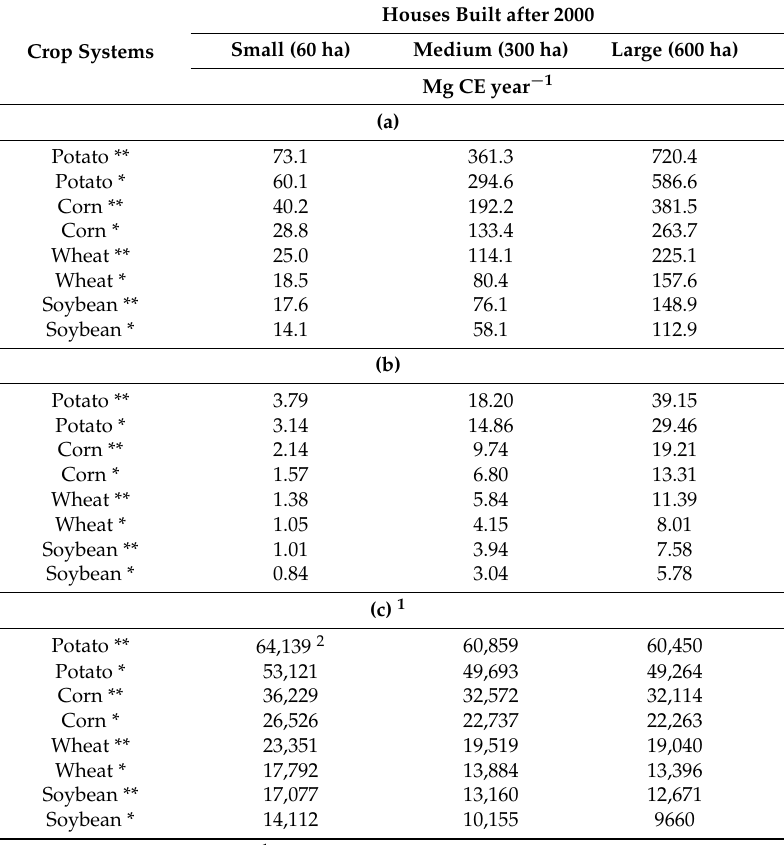
Table 4. ( a ) Total carbon equivalent (Mg CE year − 1 ) emissions estimates for irrigated and non-irrigated farming scenarios on farms containing adequately insulated houses built after 2000; ( b ) Scenarios for reduced carbon emissions (Mg CE) on small, medium, and large size farms growing irrigated and non-irrigated crop systems and planting field and farmstead windbreaks; ( c ) Potential reduction in carbon emissions due to the use of windbreaks for various farming scenarios based on 1 million ha worth of farm at each